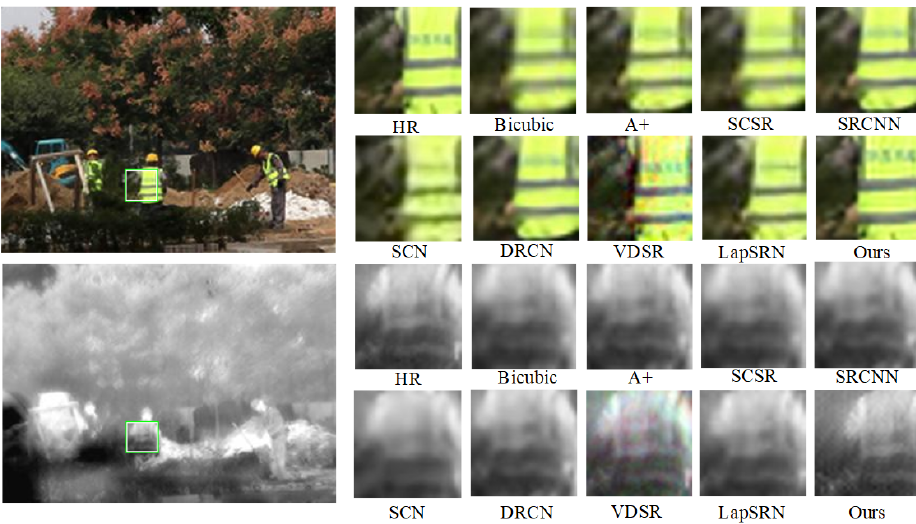
Figure 9. SR experiment results of scale 2 in